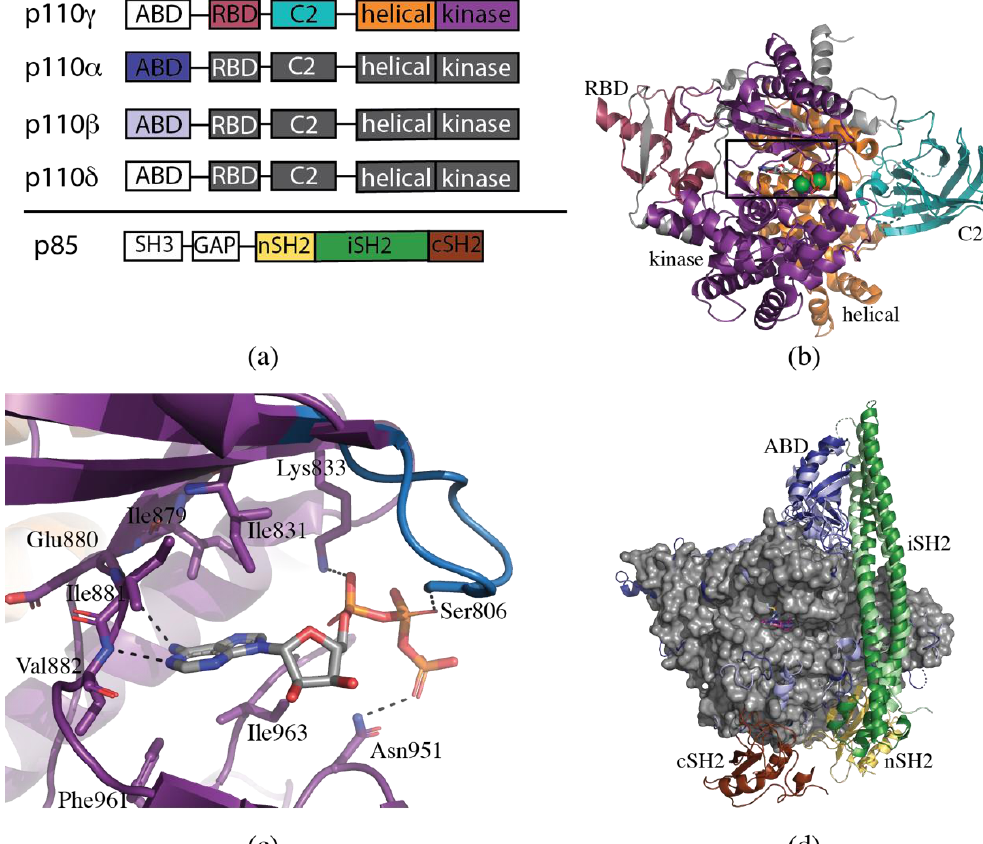
Figure 1. Structural biology of PI3K. ( a ) Domain organization of the catalytic subunits (p110) and regulatory subunit (p85) of Class I PI3K. Domains colored in white have not been crystallized in PI3K complex structures. ( b ) The structure of ∆ ABD-p110 γ in complex with ATP (PDB ID 1E8X). The domains are colored according to ( a ). Lutetium ions are shown as green ions, approximating the position of magnesium. The ATP binding site is within the black rectangle. ( c ) ATP binding site (PDB ID 1E8X). The adenine ring forms hydrogen bonds with the backbone of γ Glu880 and γ Val882 and stacks between γ Ile831 and γ Ile963. The α -phosphate interacts with γ Lys833, β -phosphate with γ Ser806 and γ -phosphate with γ Asn951. The P-loop has been highlighted in blue. ( d ) The structure of Class IA PI3K. p110 δ is shown in gray as surface representation (PDB ID 2WXL). The ABD of p110 α (dark blue, PDB ID 4OVU) and p110 β (light blue, PDB ID 2Y3A) are shown in cartoon representation, mediating the binding to iSH2 of p85 ( α , dark green; β in light green). The nSH2 from PI3K α is shown in yellow, and the cSH2 from PI3K β is shown in brown.